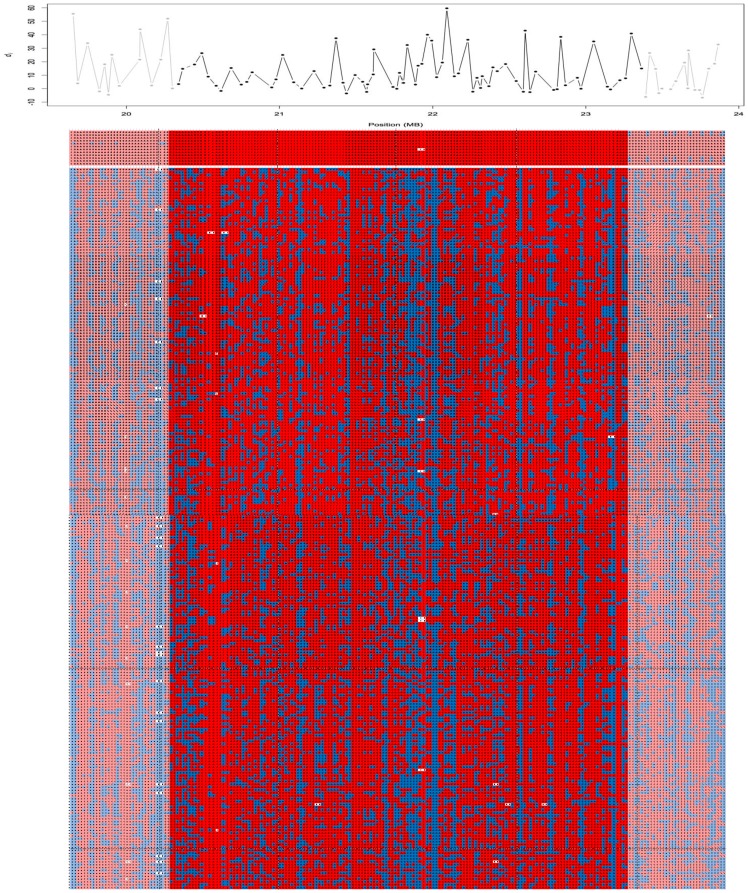
A SNP based di in the chromosome A1 region and haplotype of Cornish Rex and control populations.The upper graph shows the di value for each SNP in the region within the 3 Mb shared haplotype across all Cornish Rex cats. Below, each SNP is represented by two alleles in two contiguous boxes. Boxes colored in red represent the major allele of Cornish Rex, while the blue color represent the minor allele. Faded color starts at the end of each boundaries of the haplotype block in the Cornish Rex samples. The first 12 lines of boxes represent the haplotype of each Cornish Rex included in the analysis, while below are all the other samples included in the analysis.